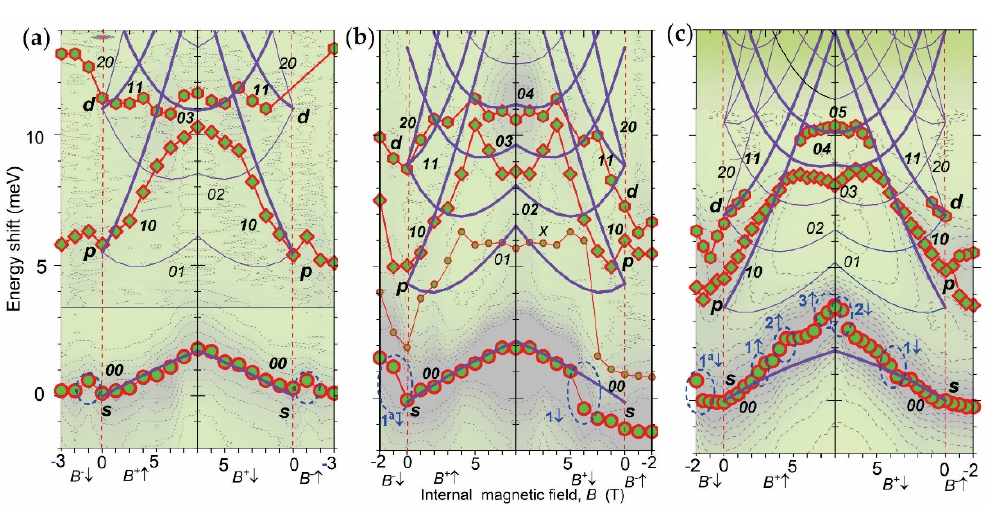
Figure 3. Peak shifts (circles − s , diamonds − p , hexagons − d, small circle − x ) versus internal magnetic field B and calculated shifts (solid curves) overlaid on the PL spectra contour plot of D01m ( a ), D07m ( b ) and D09m ( c ) InP/GaInP 2 QDs. Changes of B –field has four ranges: decrease from B ν to 0 T ( B − ↓ ), increase from 0 to 10 T-| B ν | ( B + ↑ ), decrease from 10 T-| B ν | to 0 T ( B + ↓ ) and increase from 0 T to B ν ( B − ↑ ). Dashed ovals mark s -shift